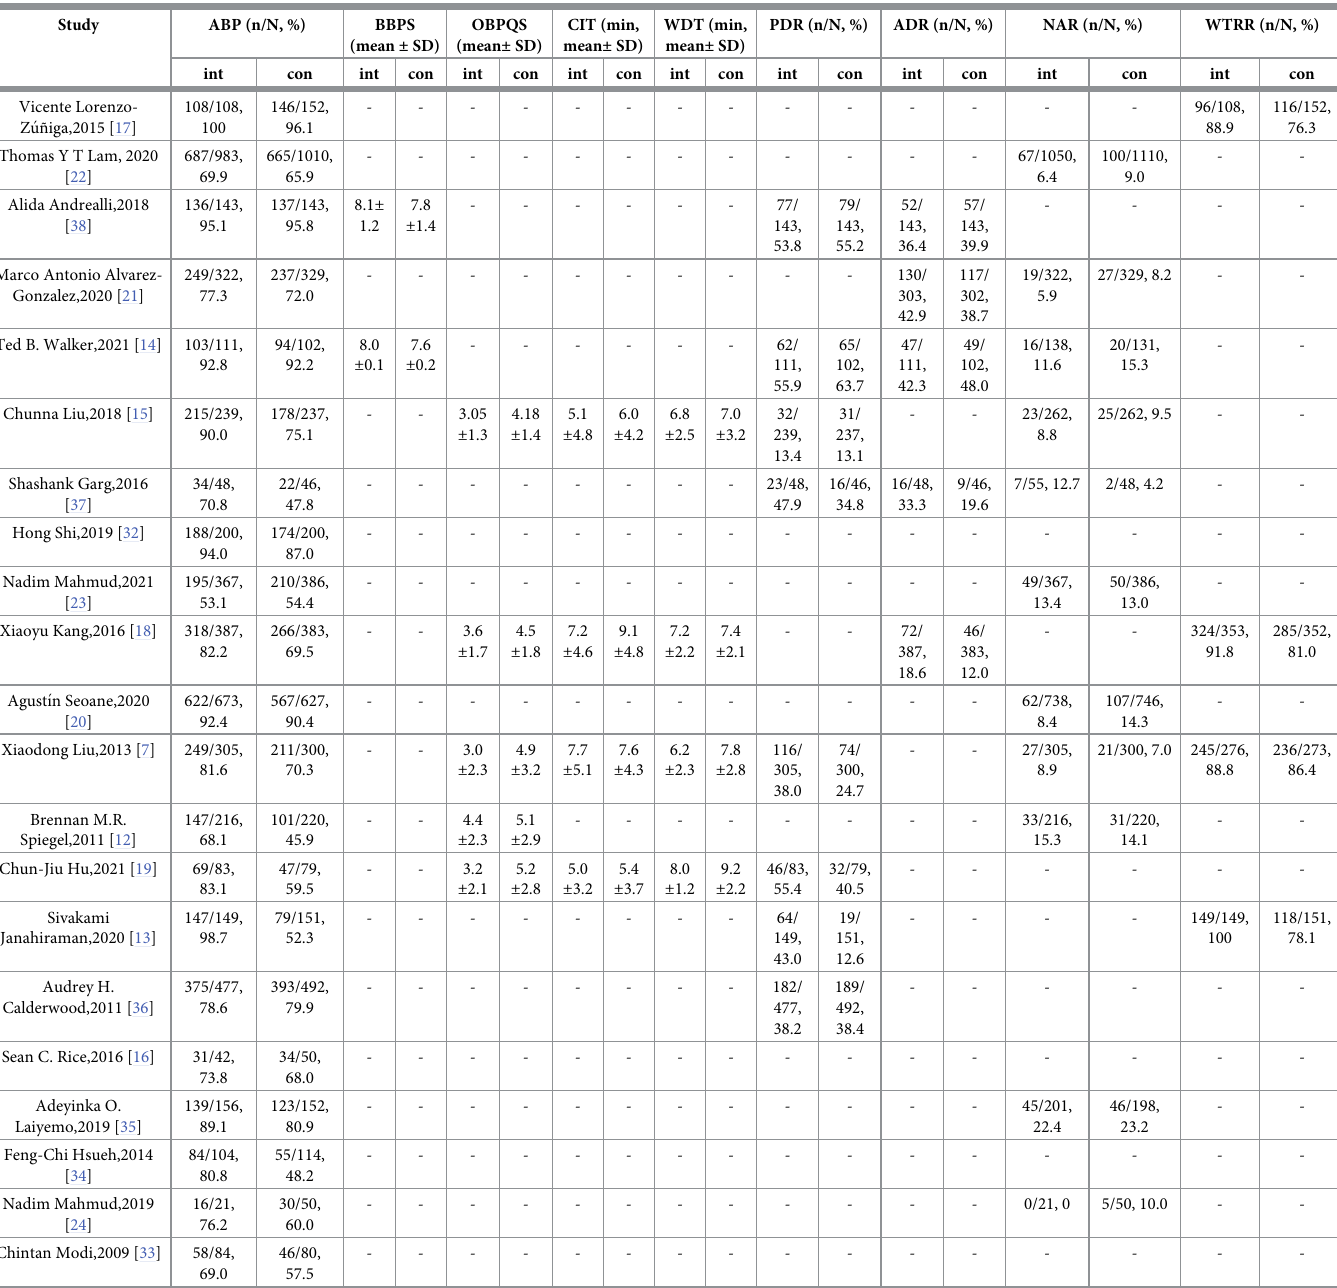
Table 2. Summary outcome indicators of studies included in the meta-analysis.